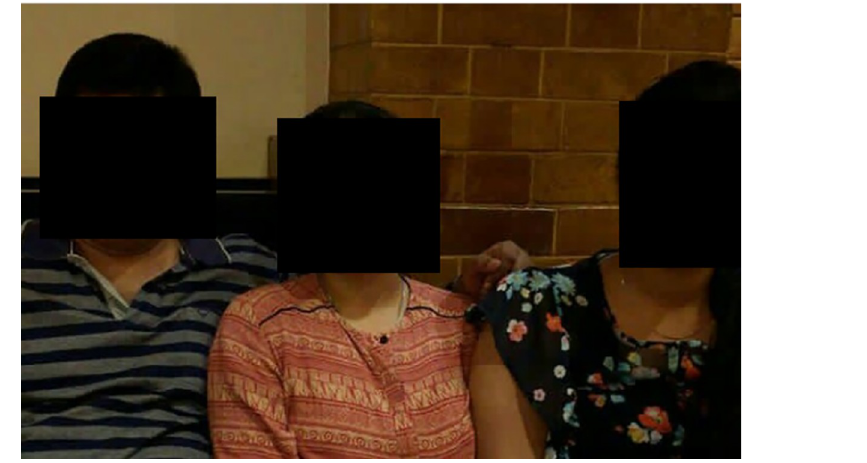
Fig 2. Friendly parents © G2, female, 15 years.